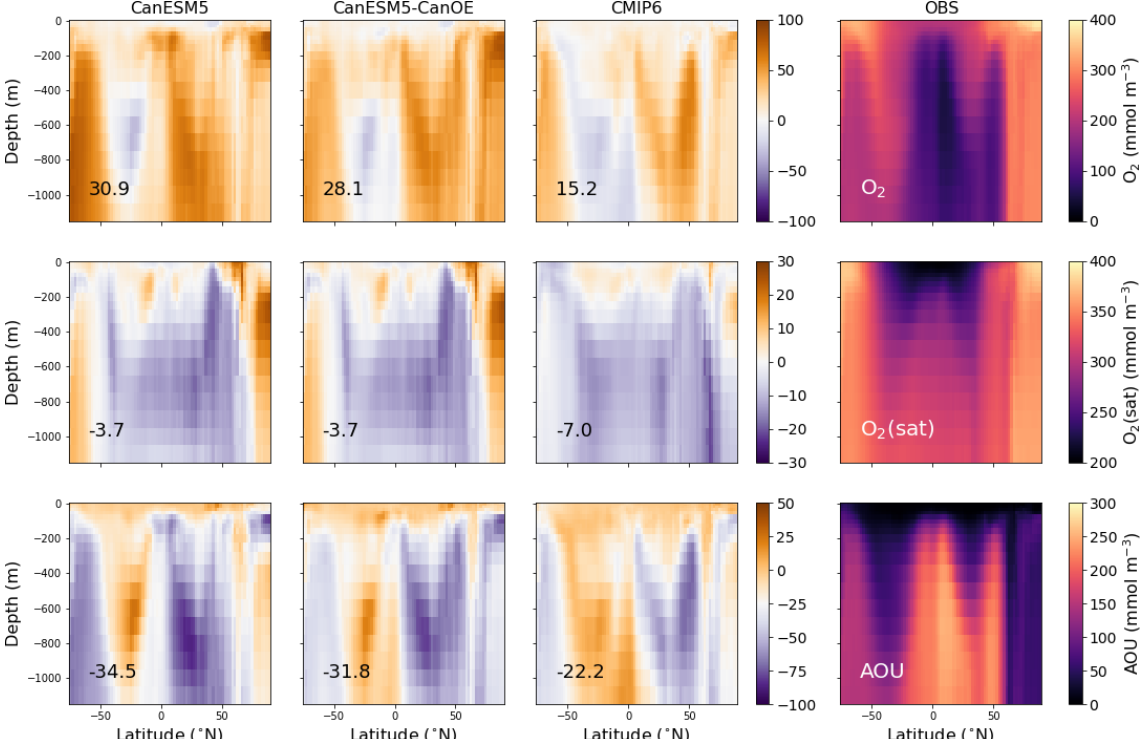
Figure 3. Latitude–depth distribution (surface to 1750m) of zonal mean oxygen concentration (O 2 ), oxygen concentration at saturation (O 2 (sat)), and apparent oxygen utilization (AOU) in mmolm − 3 for CanESM5-CanOE, CanESM5, the mean for other CMIP6 models, and observations (WOA2018). Note different colour scales for different rows. Numbers on the lower left are the mean model bias. Differences from the observation-based fields are shown in Fig. S2 in the